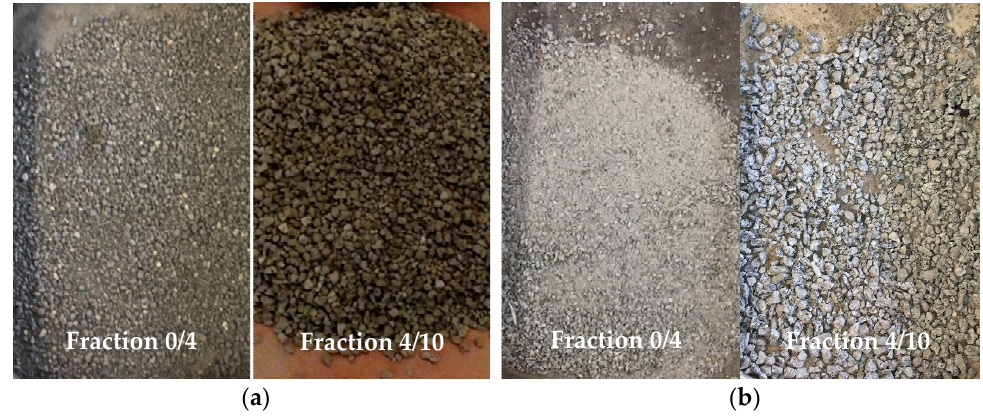
Figure 1. Materials used in this work: ( a ) steel slag aggregates (SSA) and ( b ) natural aggregates (NA).